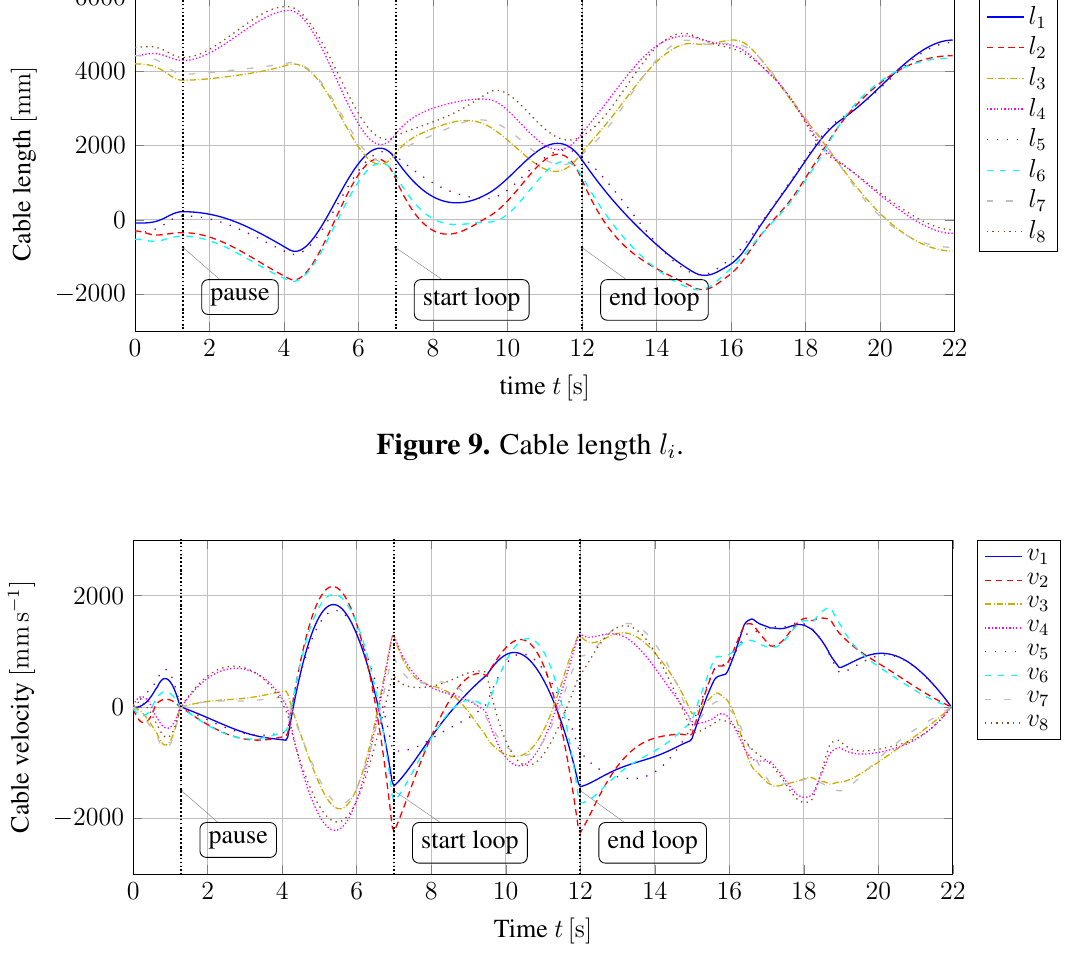
Figure 10. Cable velocity v i